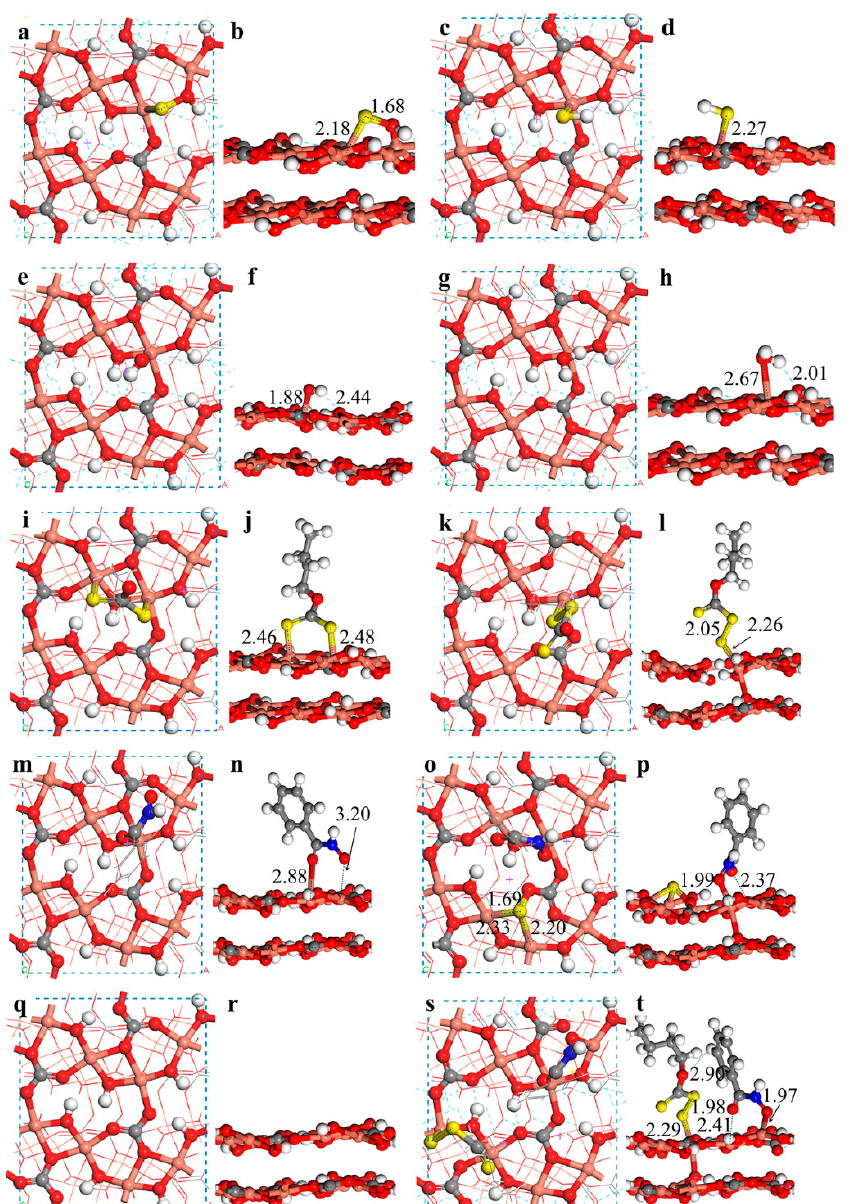
Figure 11. The adsorption model of the malachite surface in the absence of water molecules; ( a ) and ( b ) are the side and top views of the S 2- adsorbed malachite surface, respectively; ( c ) and ( d ) are the side and top views of the adsorption of SH - onto the malachite surface; ( e ) and ( f ) are the side and top views of the adsorption of OH - onto the malachite surface; ( g ) and ( h ) are the side and top views of the adsorption of water molecules onto the malachite surface; ( i ) and ( j ) are the side and top views of the adsorption of SBX onto the malachite surface; ( k ) and ( l ) are the side and top views of the adsorption of SBX onto the S 2- adsorbed malachite surface; ( m ) and ( n ) are the side and top views of the adsorption of BHA onto the surface of malachite; ( o ) and ( p ) are the side and top views of the adsorption of BHA onto the S 2- adsorbed malachite surface; ( q ) and ( r ) are the optimized ( − 201) surface of malachite; ( s ) and ( t ) are the side and top views of the co-adsorption of BHA and SBX onto the malachite surface (the balls in orange, red, gray, white, yellow, and blue colors represent copper atoms, oxygen atoms, carbon atoms, hydrogen atoms, sulfur atoms, and nitrogen atoms, respectively).